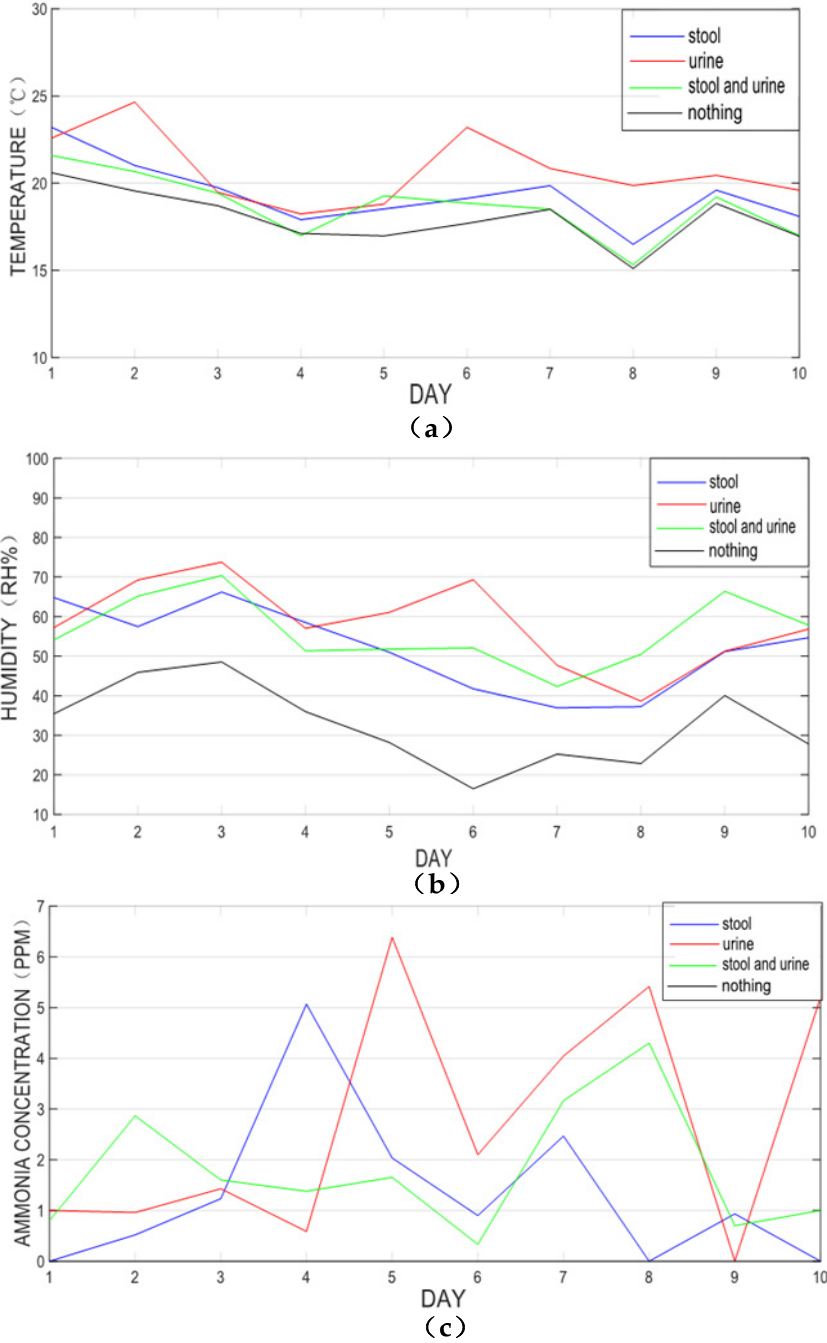
Figure 10. The data value of sample space. ( a ) Temperature data of four sample spaces. ( b ) Humidity data of four sample spaces; ( c ) Ammonia concentration data of four sample spaces.